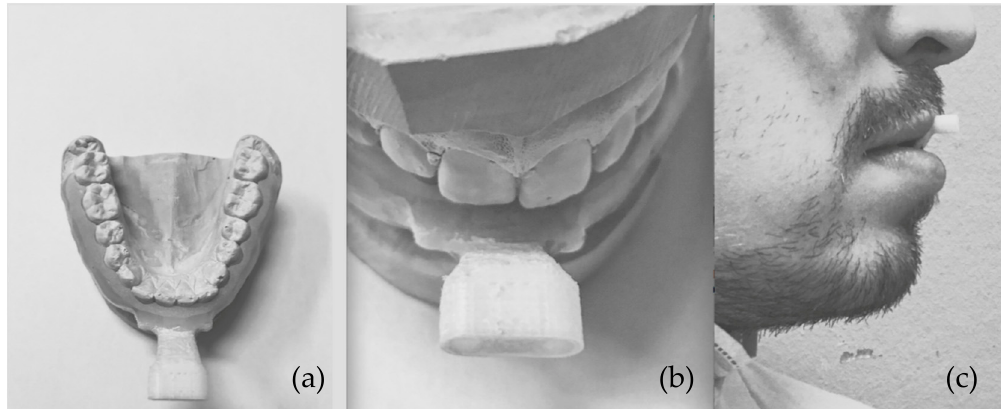
Figure 1. Dental resin model designed to fit the patient’s inferior dental arch anatomy without interfering with occlusion. ( a ) Top view; ( b ) Detail of the connector for the standardized external support carrying the markers; ( c ) side view of the object in patient’s mouth.